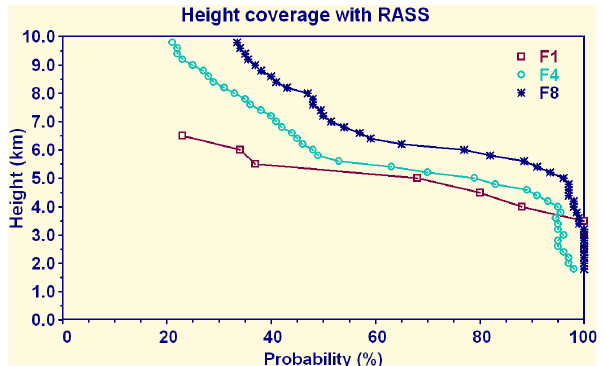
Fig. 1. Experimental results of monthly height coverage with cen- tral sources alone (F1) and simulation data using distribution pat- terns of 4 acoustic sources. at 30m from the antenna network centre (F4). and 8 sources at 30m and 60m from the centre